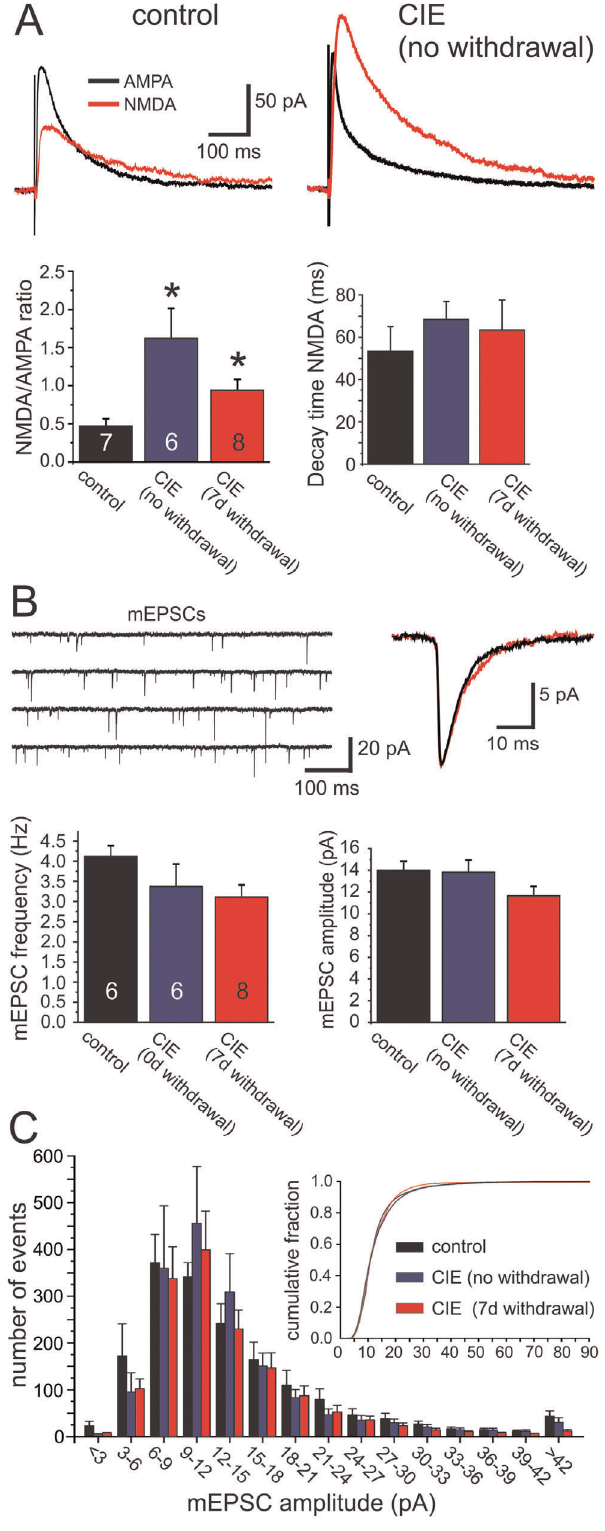
Figure 2. Chronic intermittent ethanol exposure (CIE) increases the ratio of NMDA to AMPA currents independent of altera- tions in synaptic glutamate release. A) Examples of EPSCs from neurons of a control and CIE-exposed mouse. Left: The NMDA/AMPA ratio was significantly larger in slices from control versus CIE